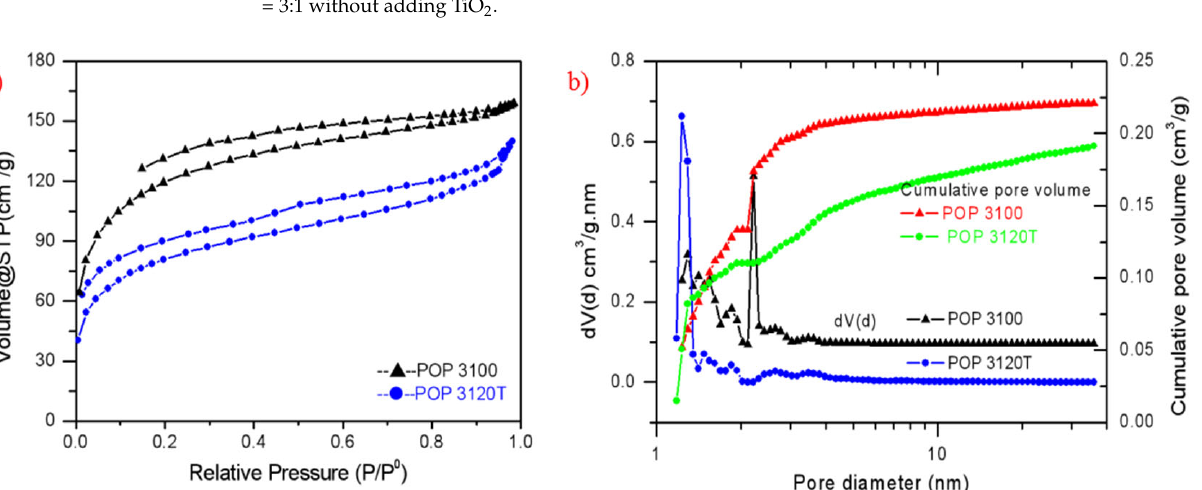
Table 1. Porosimetry analysis from N 2 sorption and bulk density results.